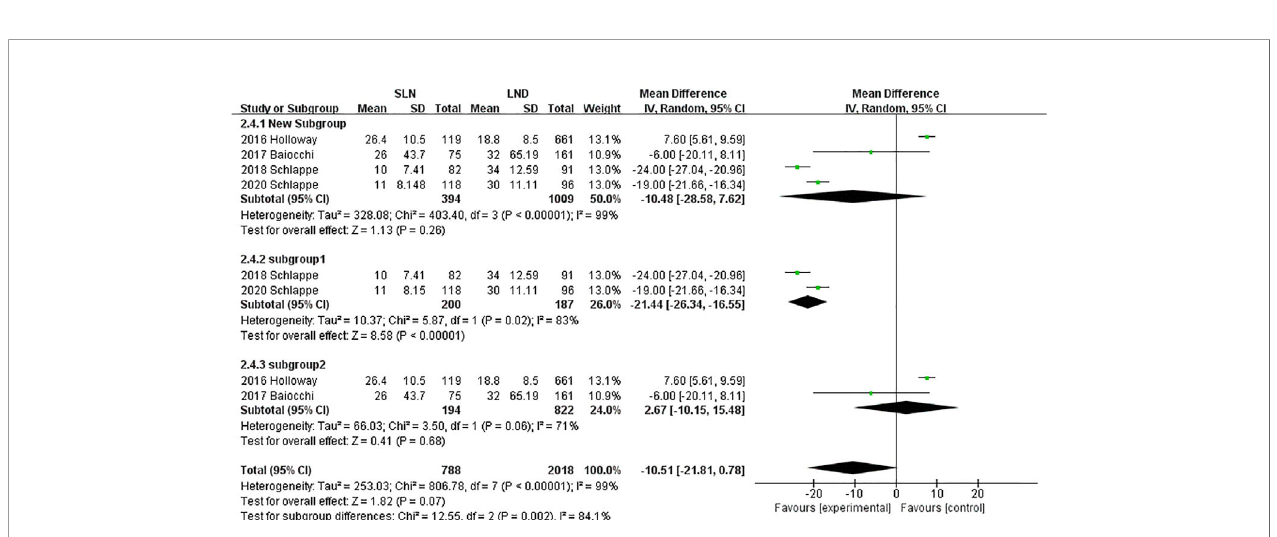
FIGURE 9 | Meta-analysis of pelvic lymph nodes removed.